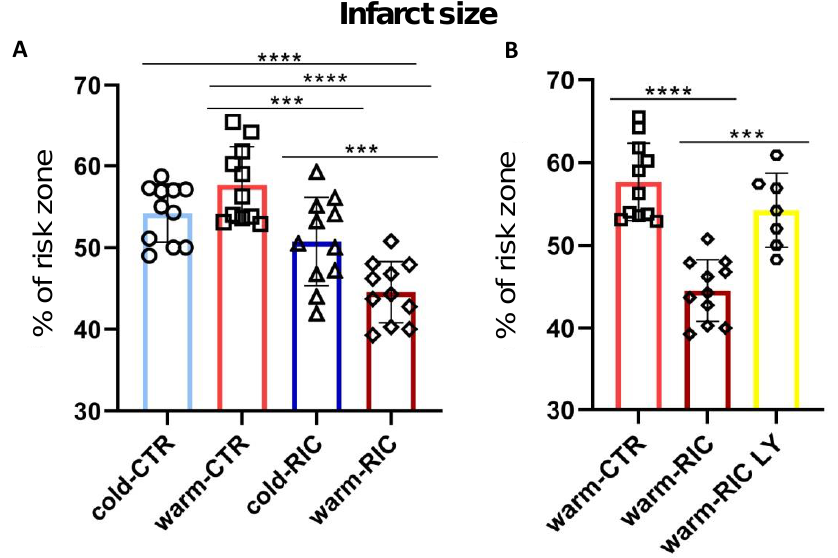
Figure 2. Infarct size (percentage of risk zone) of mice hearts. The isolated hearts of 5 different groups underwent ischemia/reperfusion protocols. The left hindlimb of anesthetized mice were subjected to remote ischemic conditioning (RIC) at cold (cold-RIC, n = 11) or warm (warm-RIC, n = 11) temperatures or exposed to cold (cold-CTR, n = 11) or warm (warm-CTR, n = 11) temperatures only. In a group of warm-RIC mice, LY294002 (5 µ M; warm-RIC LY, n = 7) was infused into isolated hearts before the induction of ischemia. In ( A ) the first four groups are reported. In ( B ), warm-CTR and warm-RIC are reported again and placed next to the warm-RIC LY group to better highlight the statistical differences between these three groups (**** p < 0.0001; *** p < 0.001).